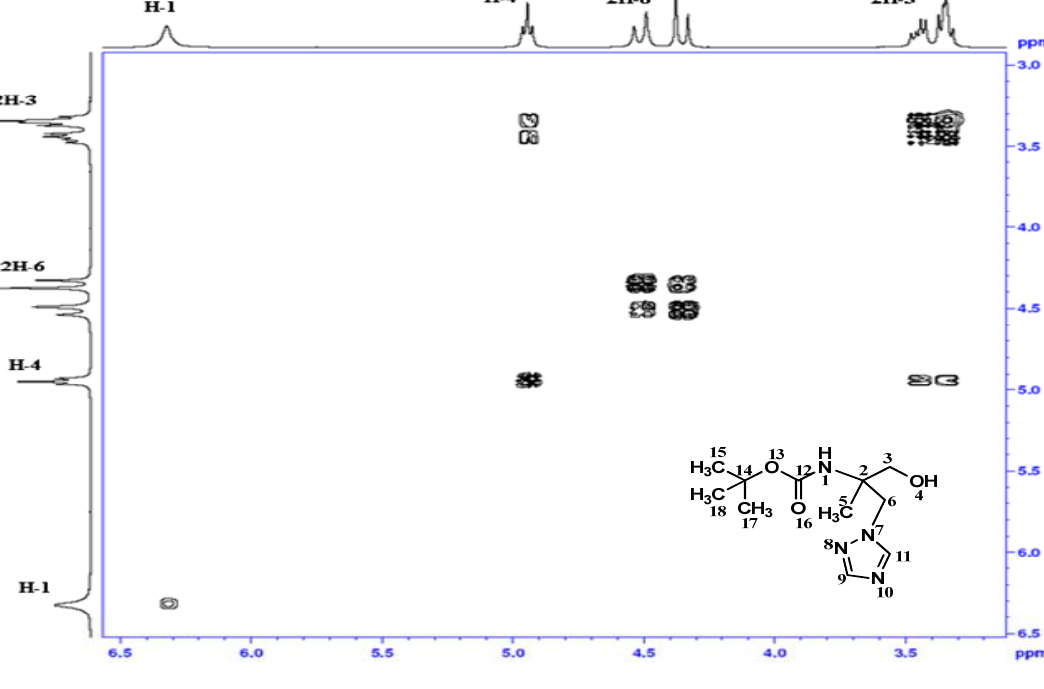
Figure 2. Homonuclear 1 H- 1 H 2D spectrum for compound 5